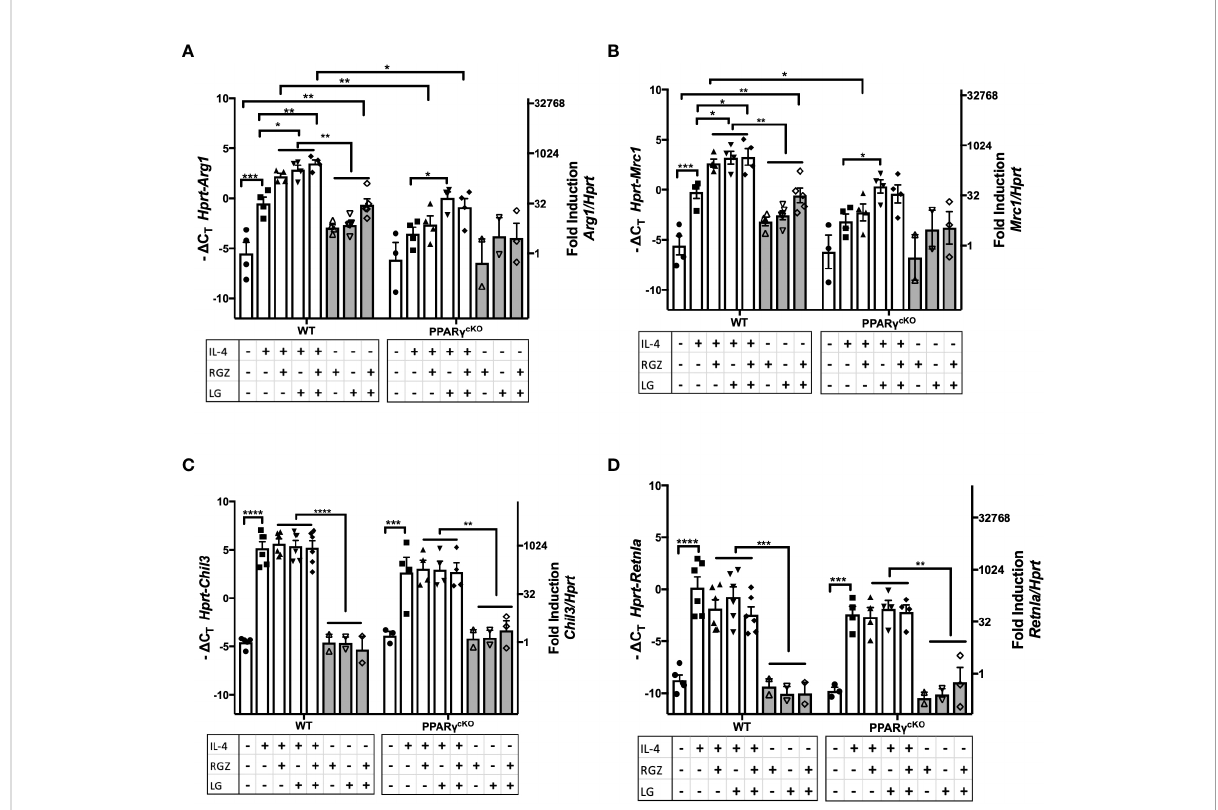
FIGURE 6 Effect of IL-4, PPAR g and RXR agonists on M2 macrophage gene expression in WT and PPAR g cKO macrophages. Thioglycollate-elicited peritoneal macrophages were harvested from age-matched WT (C57BL/6J) and PPAR g cKO mice and stimulated with IL-4 at 1ng/ml in theabsence or presence of 1 m M of RGZ and/or 1 m M of LG for 48 hr, and RNA was processed. Gene expression of Arg1 (A) , Mrc1 (B) , Chil3 (C) , and Retnla (D) were quanti fi ed by qRT-PCR. Data were pooled from 3 independent experiments and is presented as - D C T (left y-axis) and fold induction (2 - DD CT value; right y-axis), mean ± SEM. Statistical analysis (2-way ANOVA with Sidak ’ s multiple comparison post-hoc test) was performed on the - D C T values. ****p <0.0001, ***p<0.001, **p<0.01, and